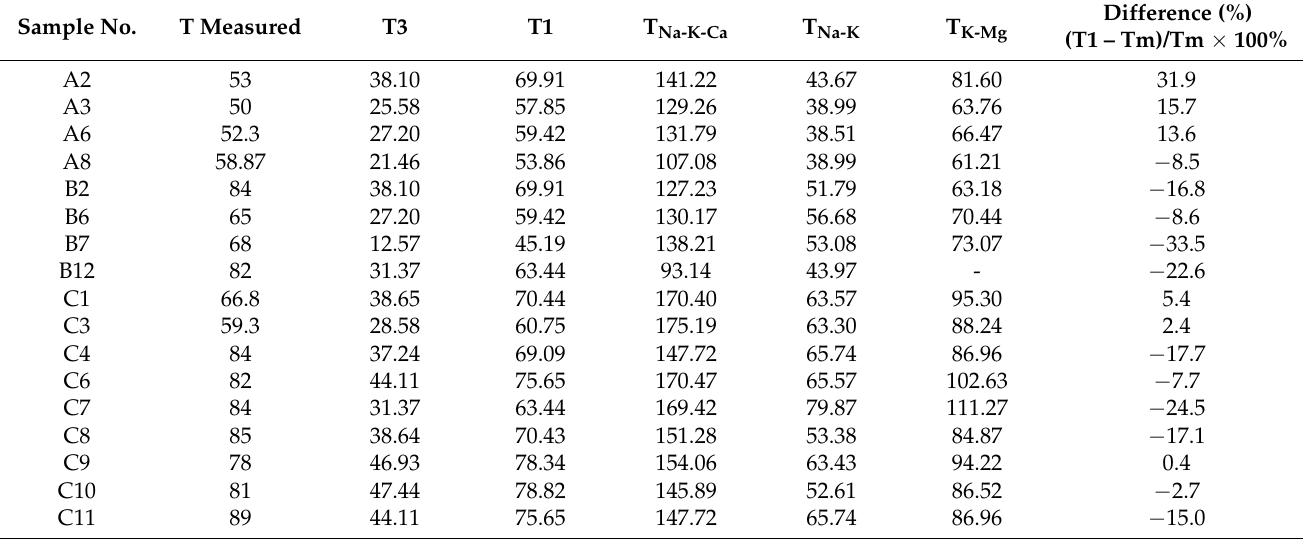
Table 4. Calculated geothermal reservoir t temperatures of the geothermal fields in the study area (T in ◦